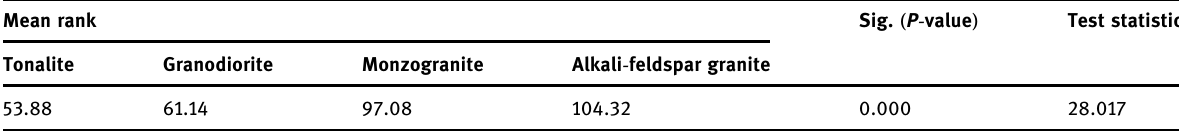
Table 4: Kruskal – Wallis test for tonalite, granodiorite, monzogranite and alkali - feldspar granite